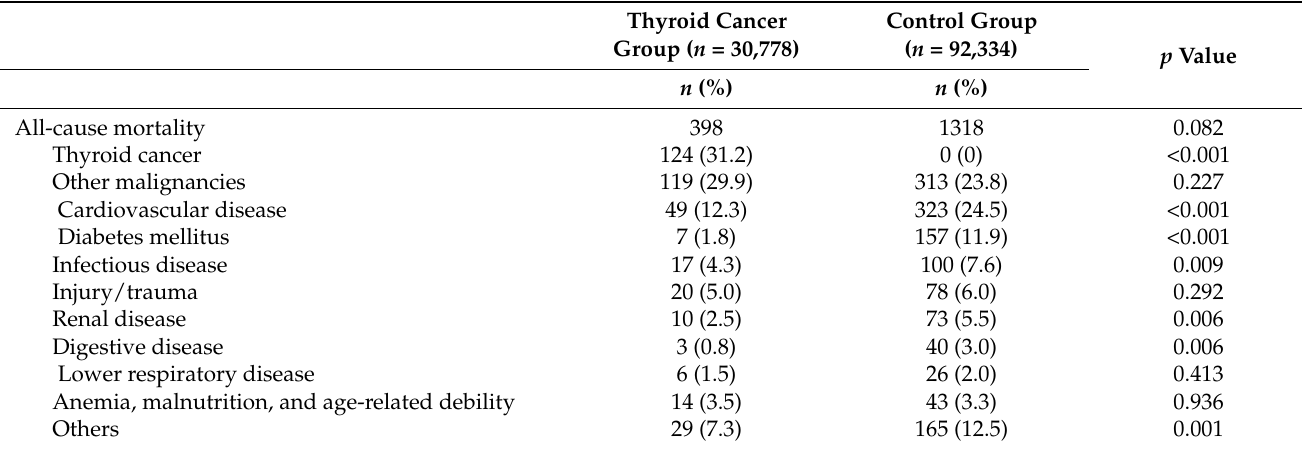
Table 2. Incidence of all-cause and cause-specific mortality in the thyroid cancer group and the control group.